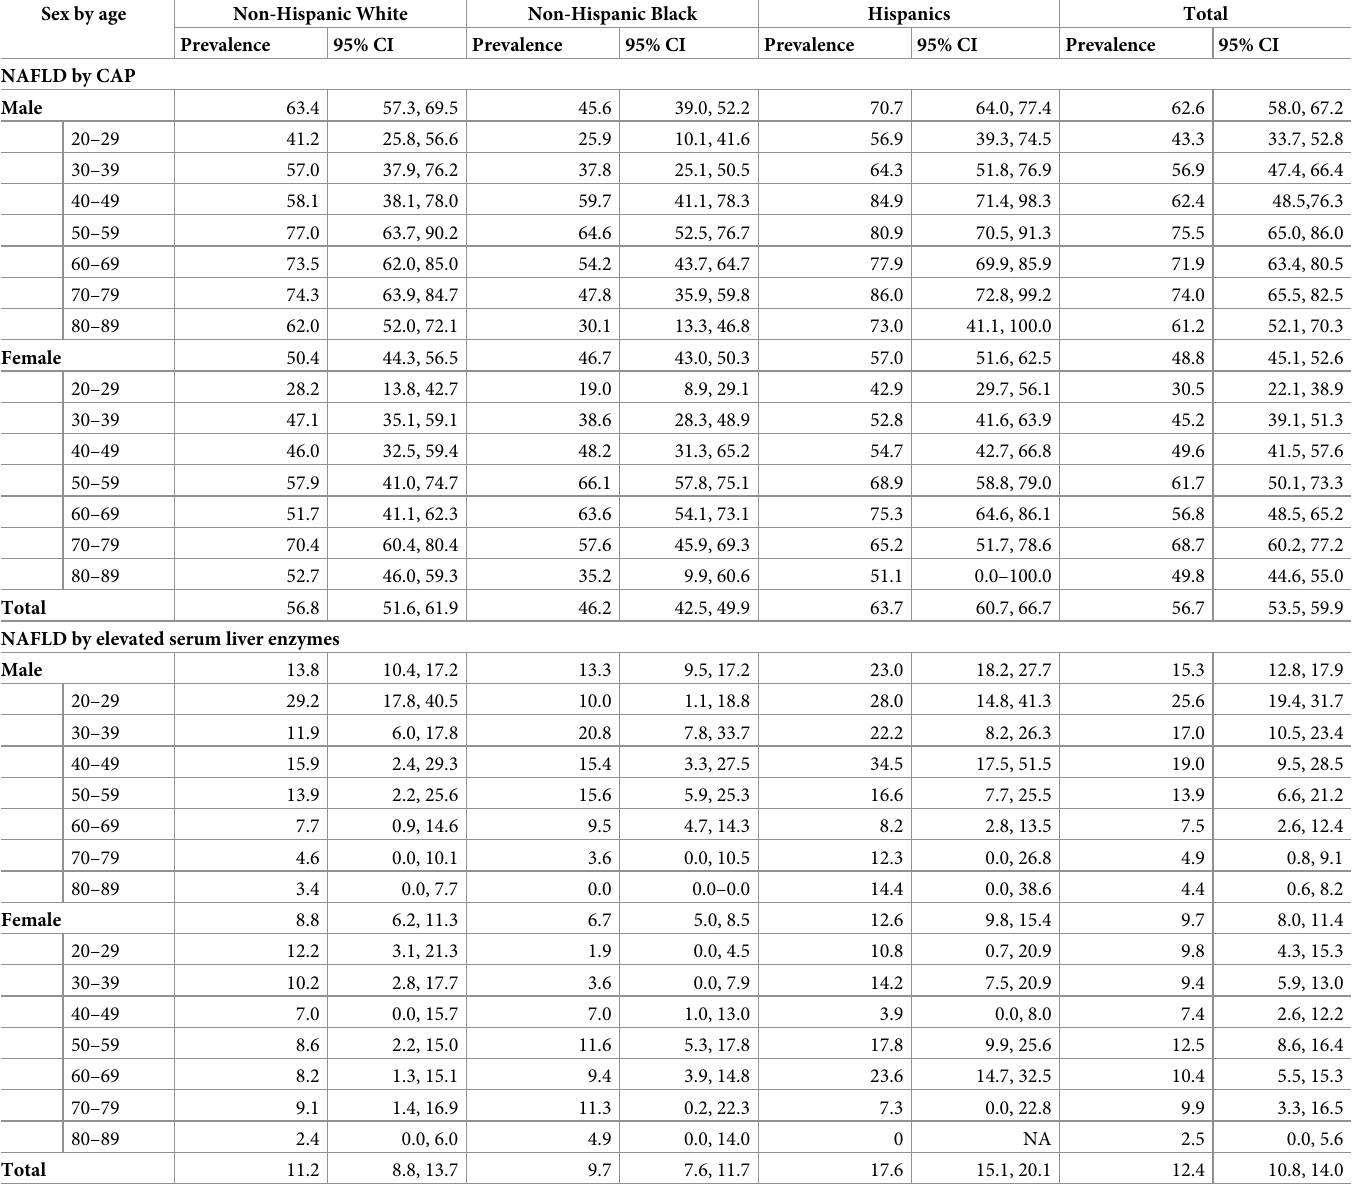
Table 3. Weighted prevalence of NAFLD using the two definitions by age group, sex and race/ethnicity. Sex by